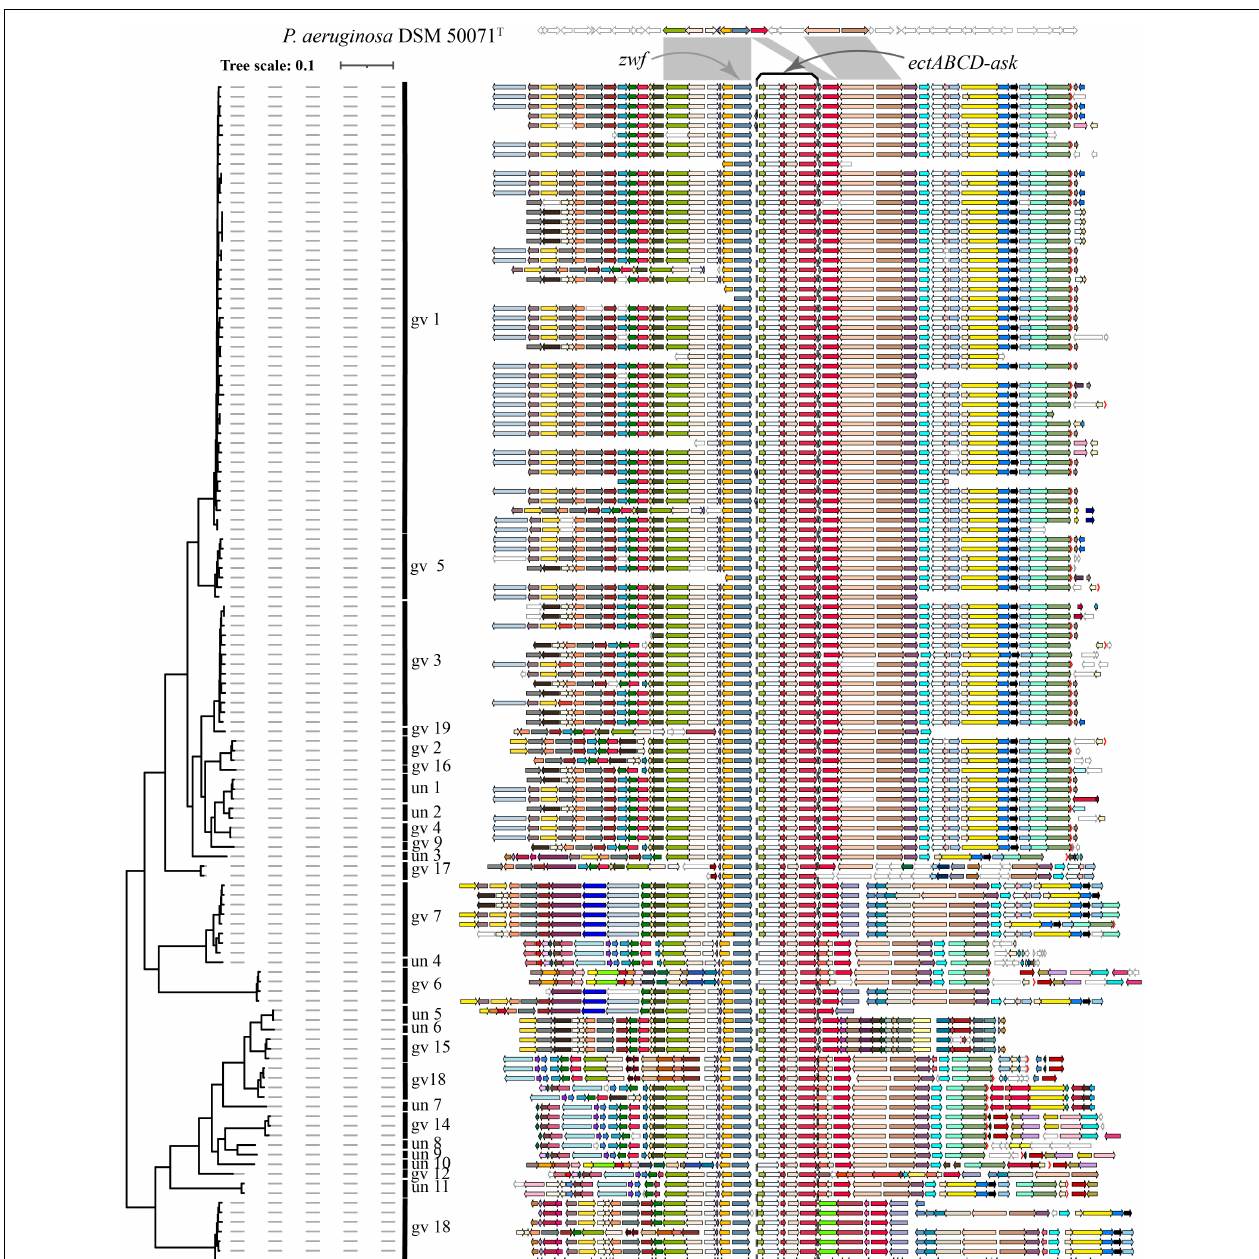
FIGURE 5 | Visualization and mapping of the ectoine biosynthesis gene cluster ( ectABCD-ask ) and its flanking genomic elements (20 genes) to Figure 2 in 123 P. stutzeri complex genomes. Gcluster was used to visualize and map the ect cluster to the phylogeny shown in Figure 2 , displayed in a rectangular shape. Gcluster was run using three inputs, including (1) a directory containing the 123 genomes in GenBank format, (2) a list of genes of interest, in which each row contains a locus tag of the ectC gene from each of the 123 genomes, and (3) a tree file of Figure 2 in Newick format. Then, the generated SVG map was edited by Adobe Illustrator to delete strains name, remove outgroup branches and add the genomovar information. At the top, these contexts are compared with P. aeruginosa DSM 50071 T , which has no ect cluster but similar organization of flanking genes in its genomes. Genomic contexts have been reorientated around ectC , and parts of flanking genes were found to be missing from certain draft genomes. ectABCD-ask is marked by a black rectangular dashed box. Homologous gene clusters are filled in different colors; unique genes, pseudo genes and RNA genes are in white, with black, deep-gray and red borders, respectively.